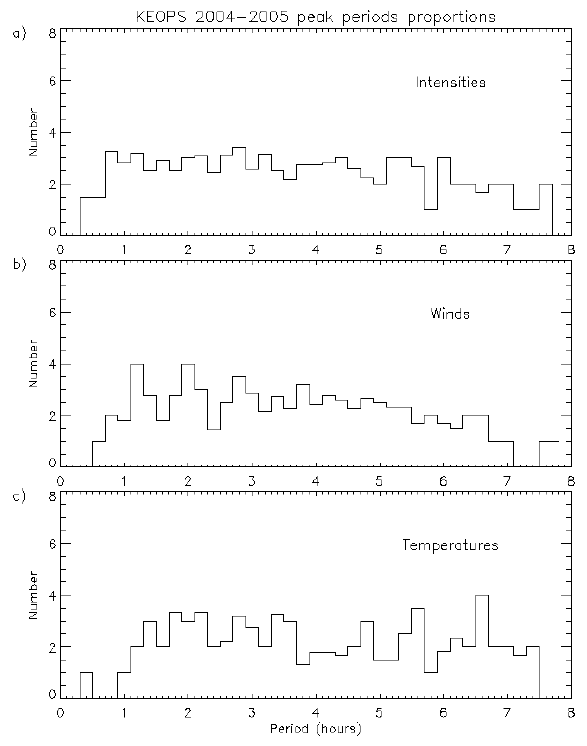
Fig. 13. Proportion of gravity wave periods for the north, east, south, and west directions compared with the number per night, from KEOPS data over the 2004–2005 season: (a) intensities, (b) winds, and (c)